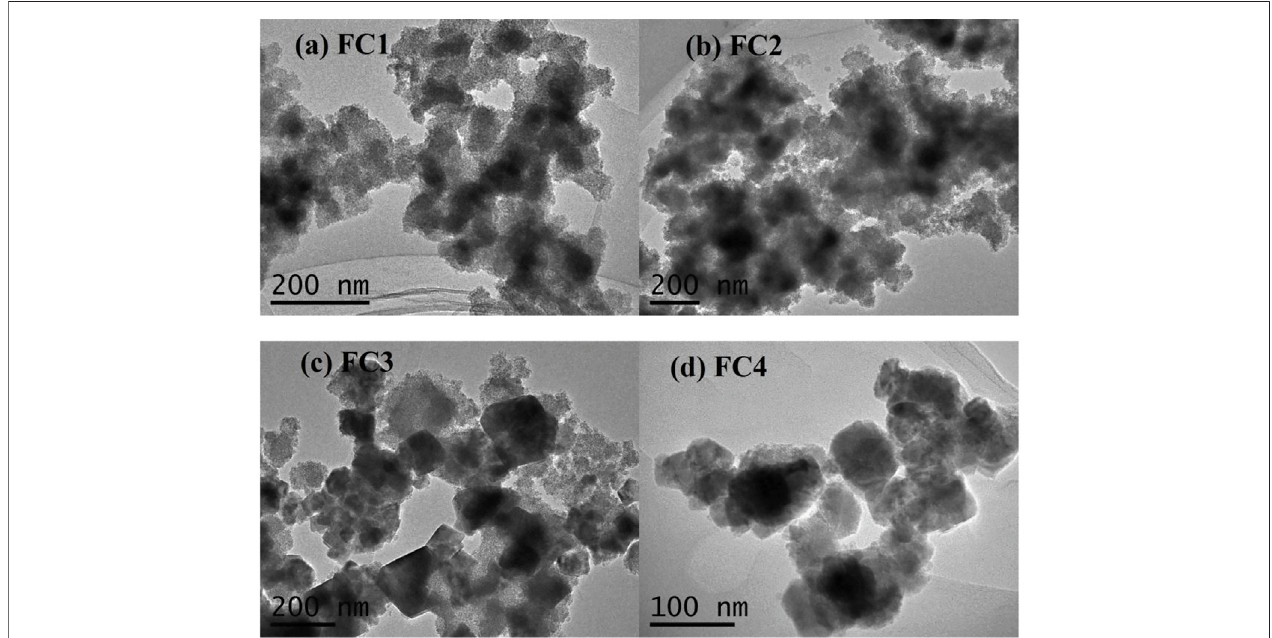
FIGURE 2 | TEM images of the Fe-Cu binary oxides: (A) FC1, (B) FC2, (C) FC3 and (D) FC4.